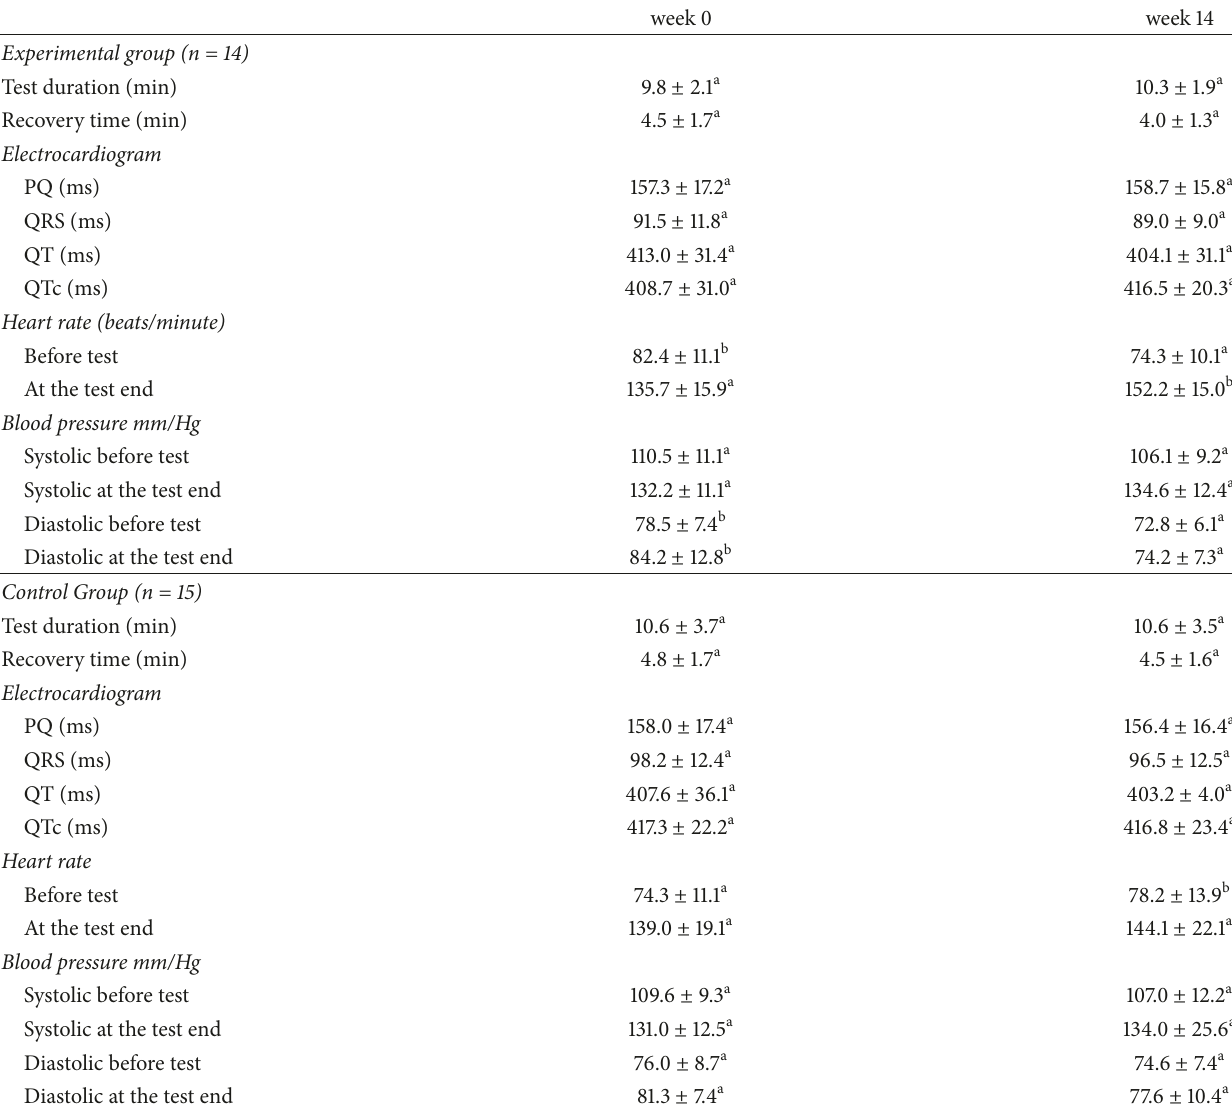
Table 3: Cardiovascular function parameters of experimental and control